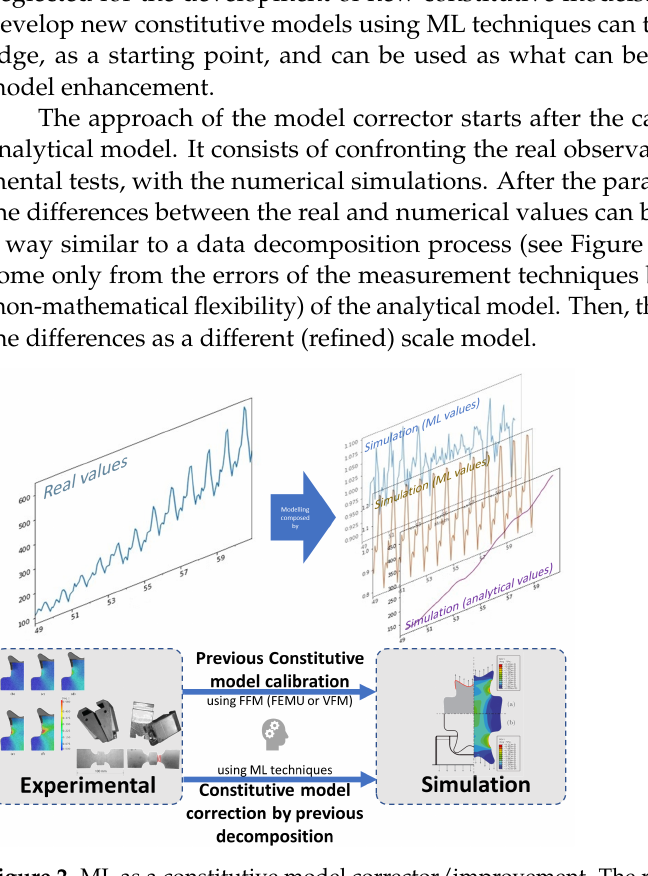
Figure 2. ML as a constitutive model corrector/improvement. The real behaviour (measured values) is decomposed into the analytical model (retrieved after a full-field calibration process) and the ML model. The training of the ML model uses the data obtained after the